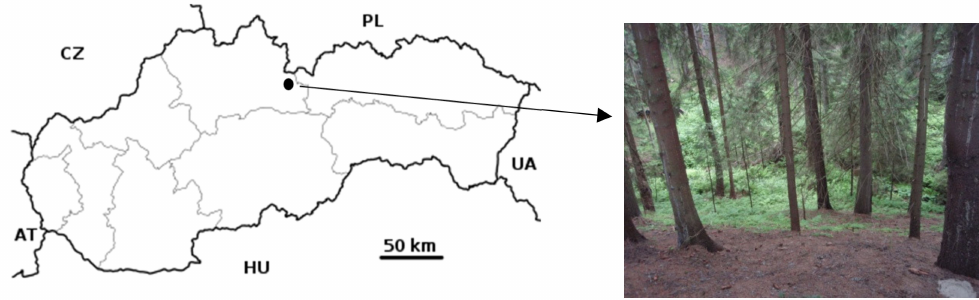
Figure 1. The study location on the High Tatras foothill. On the right is the investigated hillslope directly above the Dovalovec